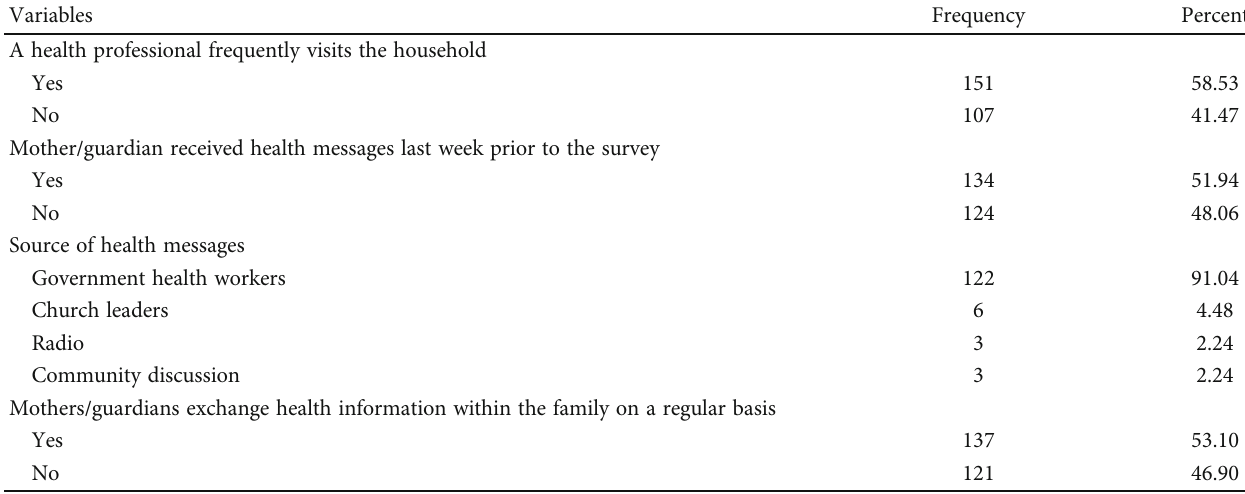
Table 2: Baseline Health care related information of children caregivers respondents in Debre Tabor comprehensive specialized hospital, Northwest Ethiopia, 2021 ( n = 258